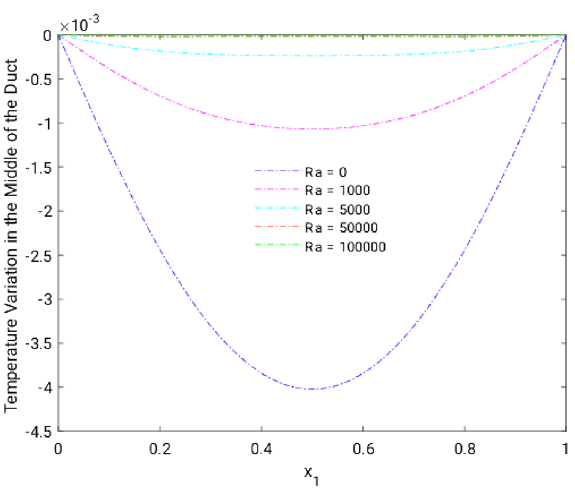
Figure 12. Temperature variation along the line x 2 = 0.5 for different Ra, in the absence of external